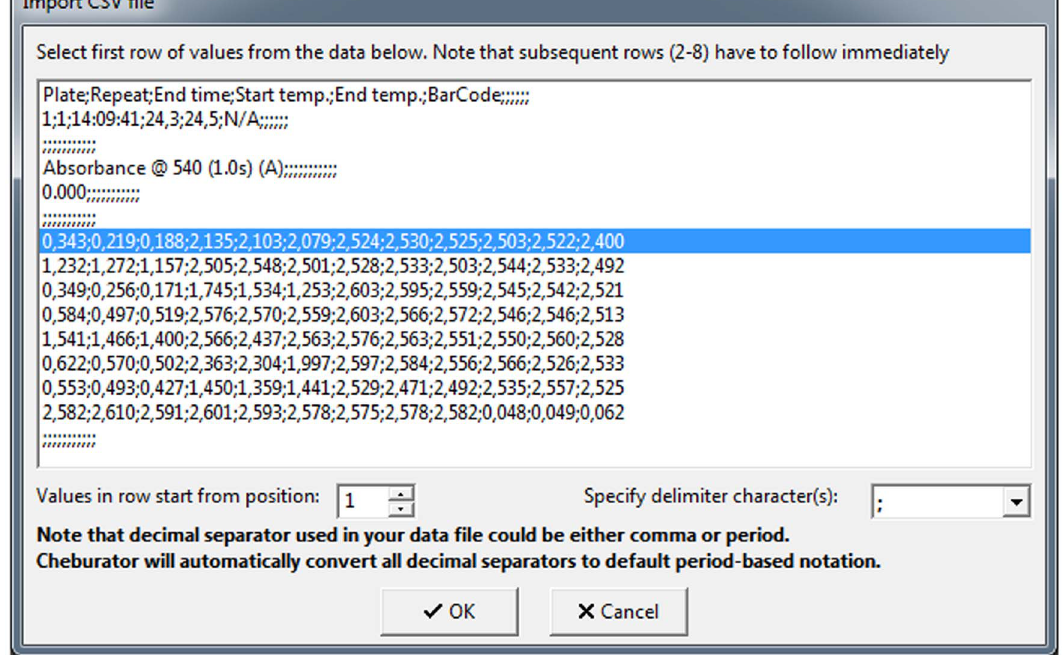
Figure 3. The built-in converter for.csv files. The line containing the data from the first row of the plate is selected in the picture. Other rows have to follow immediately after the first row. All rows before and after the plate data will be discarded. Each row is then divided into separate values using the delimiter specified in the combo box below (semicolon is the default, but other delimiters are also supported). Since each row could contain more values than the number of wells, the user also has to specify in the edit box below which value in the row will be treated as the optical density value for the first well. Data for the subsequent wells have to follow immediately after, separated by delimiters. Note that the user can use a period or comma as the decimal separator for data files. Cheburator will automatically convert all decimal separators into periods, which are the default.